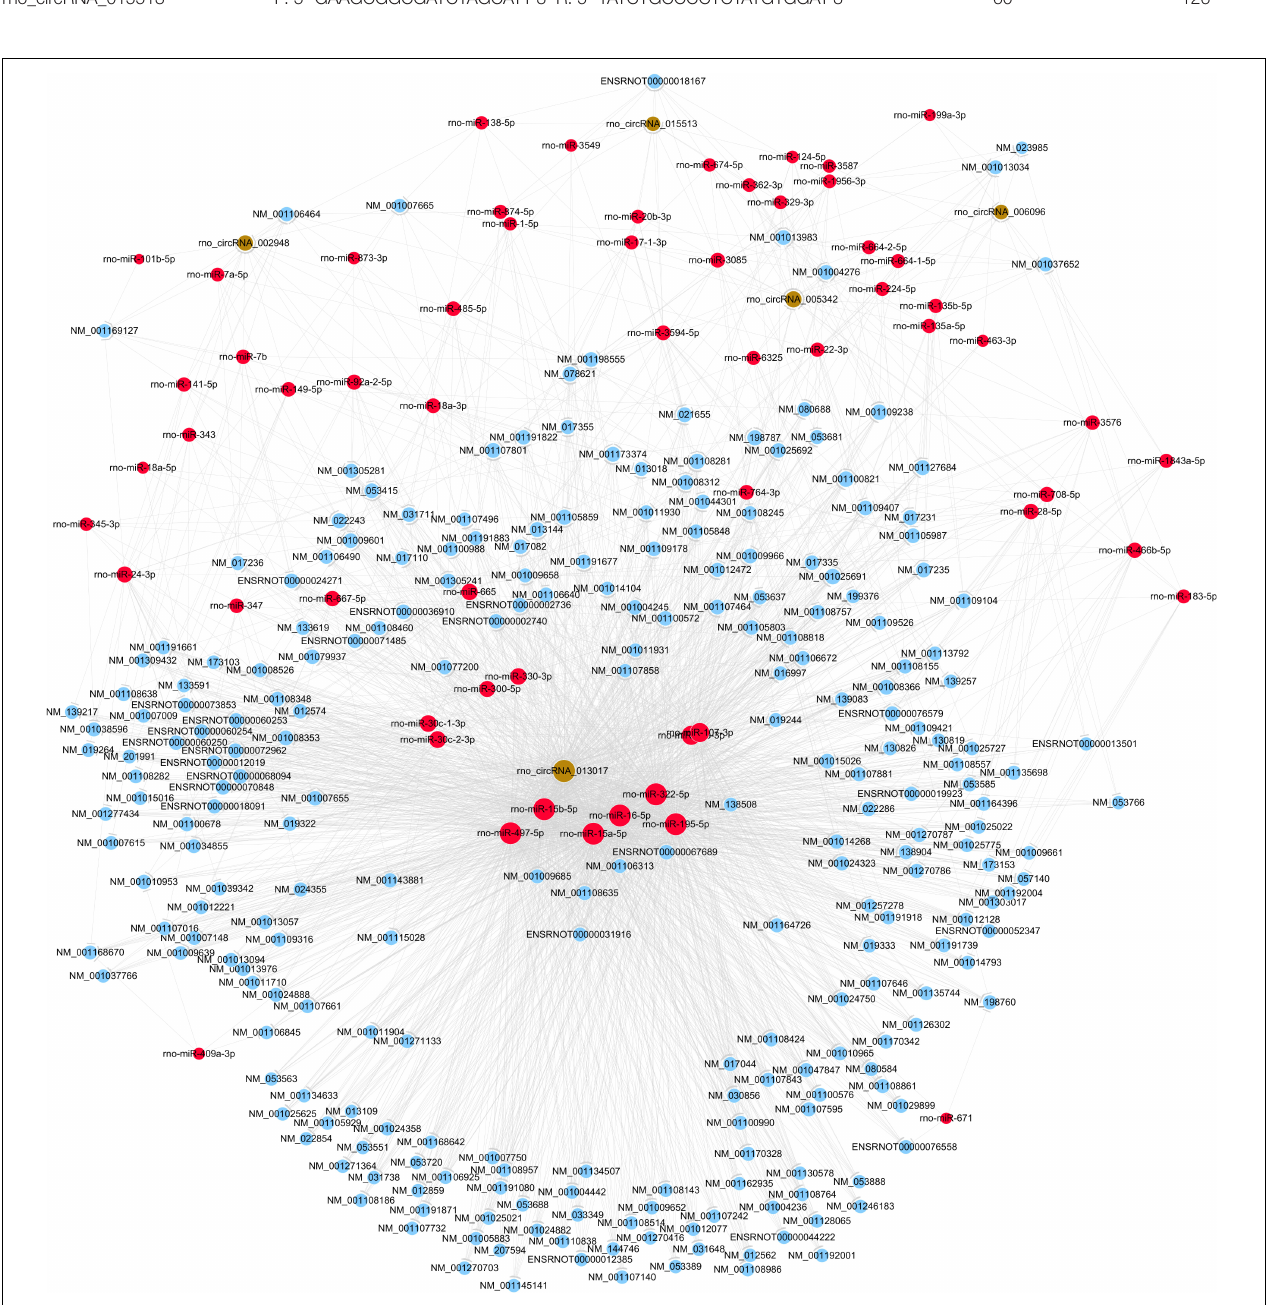
FIGURE 4 | The circRNA/miRNA/mRNA network analysis. The network included the 5 circRNAs, 60 miRNAs, and 253 mRNAs (Nodes with red color are miRNAs; nodes with light-blue color are mRNAs; nodes with brown color are circRNAs).